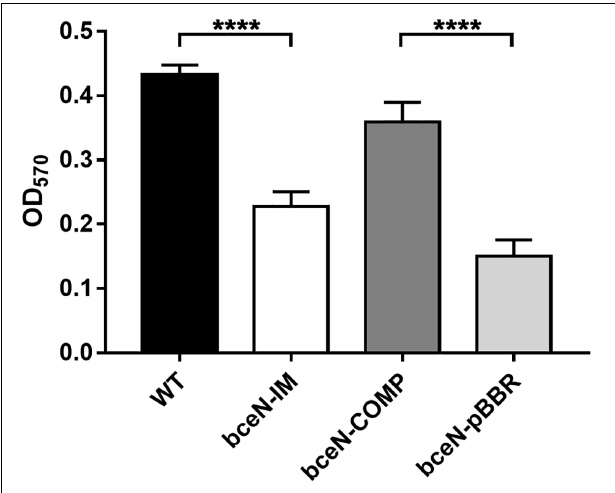
FIGURE 3 | Biofilm production in P. phymatum wild-type and mutant strains. The cells were incubated in nitrogen limited (A)BM minimal medium at 30 ◦ C for 5 days before biofilm production (OD 570 ) was quantified. Three independent biological replicates of each strain were assayed. Wild-type (WT) and the complemented (bceN-COMP) strains produced significantly more biofilm than the mutant (bceN-IM) and the mutant containing the empty vector (bceN-pBBR), respectively. Error bars indicate the standard error of the mean (SEM). **** p -value <